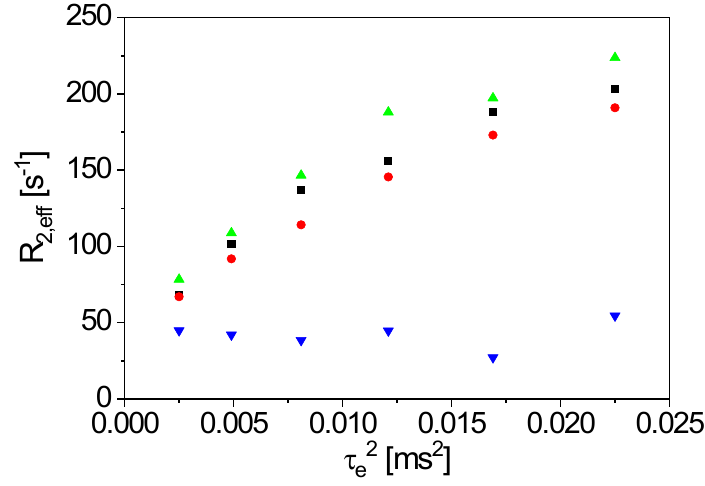
Figure 10. R 2,eff ( τ e 2 ) for an anode slurry of 48.5% w / w graphite, 1% w / w CMC and 0.5% w / w carbon black, measured with the bent figure-8 coil on top and on the bottom of the horizontally fixed sample tube ( (cid:4) : bottom, 20 h; • : top, 20 h; (cid:78) : bottom, 7 days; (cid:72) : top, 7 days. R 2,eff is larger at the bottom than at the top of the tube for both waiting times. R 2,eff is clearly larger at the bottom of the sample with a 7 day waiting time ( (cid:78) ), while value at the top ( (cid:72) ) approaches the values for doped